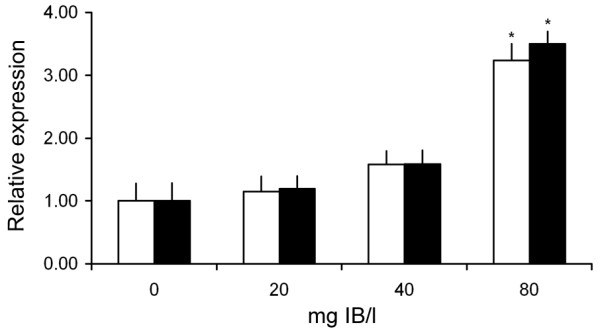
Relative gene expression of target gene Ltb4dh in Daphnia magna following a 24 h exposure to ibuprofen. Mean relative expression (n = 3) ± SD of target gene Ltb4dh (amplification efficiency E = 1.060 ± 0.042) without normalisation (white bars) or with normalisation (black bars) to normalisation factor NF3 based on the geometric mean of Act, GAPDH and UBC (gene name abbreviations as Table 1). Expression levels are displayed relative to the mean control level. An asterisk (*) indicates a significant difference (p < 0.05) between the highest treatment and any other treatment.